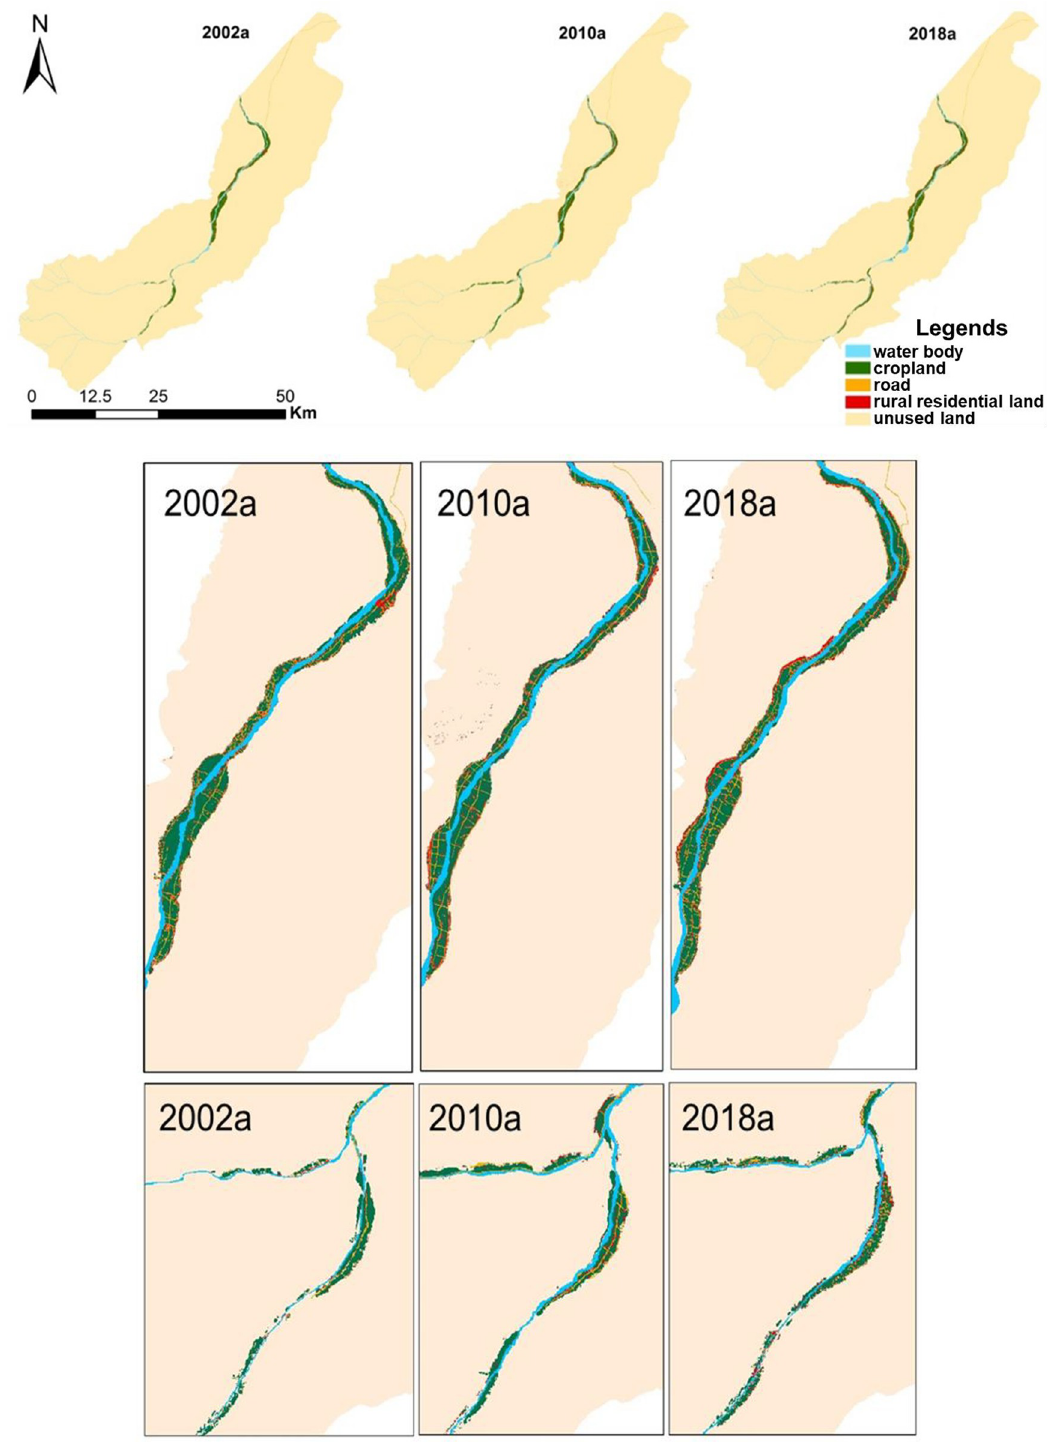
Fig 2. Classification map of land uses in the study area. (Categorical data are from the Landsat Thematic Mapper images of the United States Geological Survey [https://earthexplorer.usgs.gov] [Path/Row number: #148 #34; Date: 2002/06/22; 2010/08/23; 2018/ 05/09]. Validation data are from the MSS&PAN images of the GF-1 Satellite in 2018. Those data products are at level 1A and cloud coverage was less than 10%. Furthermore, 100 training samples were selected from each class by using support vector machine. The separability of the sample is more than 1.9, and the overall classification accuracy reaches 80%, The classification results of GF-1 are consistent with those of LANDSAT in 2018). https://doi.org/10.1371/journal.pone.0275241.g002 PLOS ONE | https://doi.org/10.1371/journal.pone.0275241 September 29,